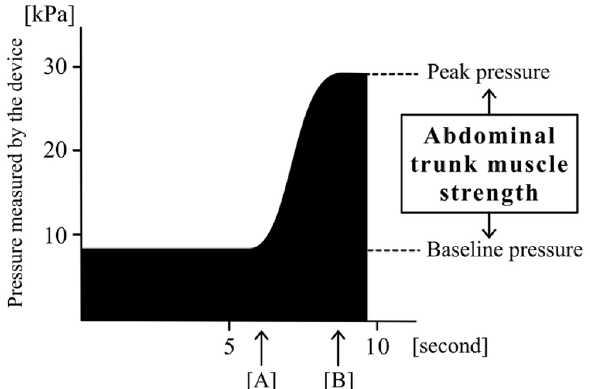
Figure 2. This waveform shows the time course of the pressure measured by the cuff during measurement mode. ( a ) The point at which the subject started to contract the abdominal trunk muscles against the pressure. ( b ) After the pressure reached a peak, it automatically decreased as the air in the cuff was released.